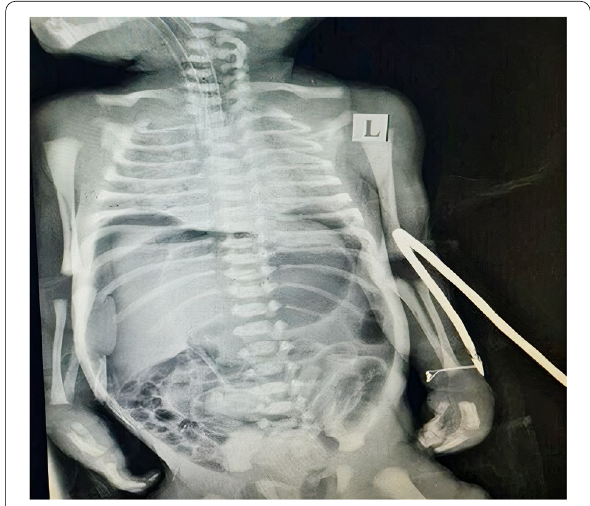
Fig. 2 CXR showing diffuse lung infiltration and incidentally found